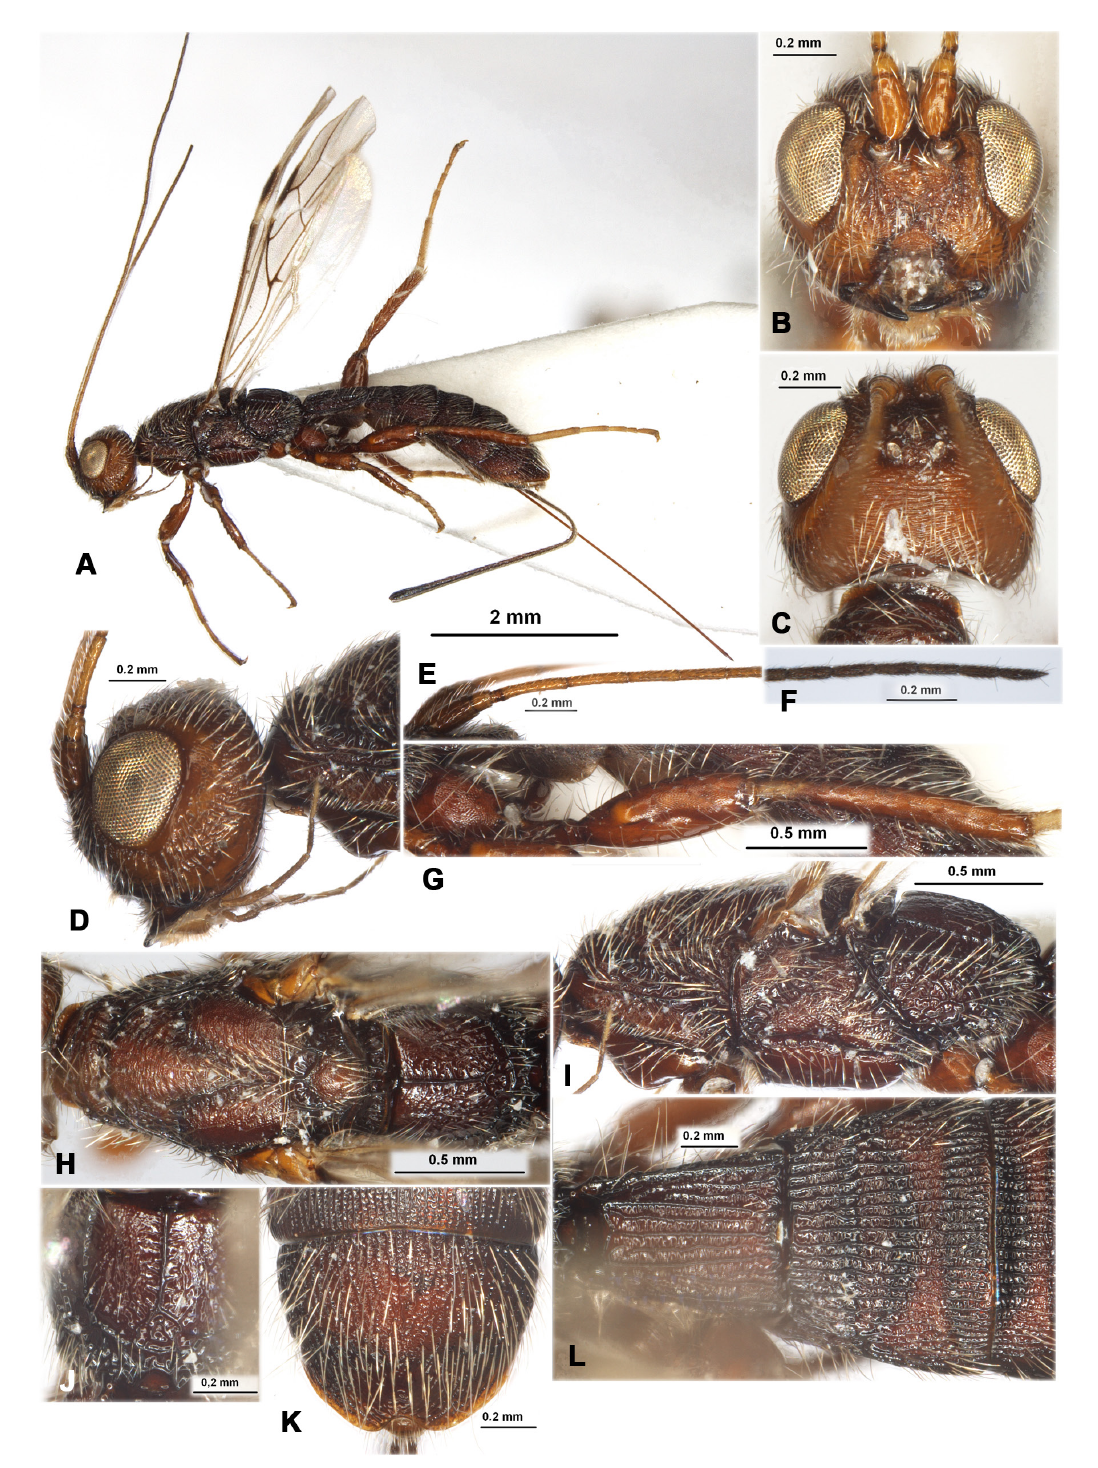
Fig. 43. Rhaconotinus ( Rh. ) albosetosus Belokobylskij sp. nov., holotype, ♀ (RMNH). A . Habitus, lateral view. B . Head, front view. C . Head, dorsal view. D . Head, lateral view. E . Basal segments of antenna. F . Apical segments of antenna. G . Hind leg. H . Mesosoma, dorsal view. I . Mesosoma, lateral view. J . Propodeum. K . Six metasomal tergite, dorsal view. L . First to third metasomal tergites, dorsal